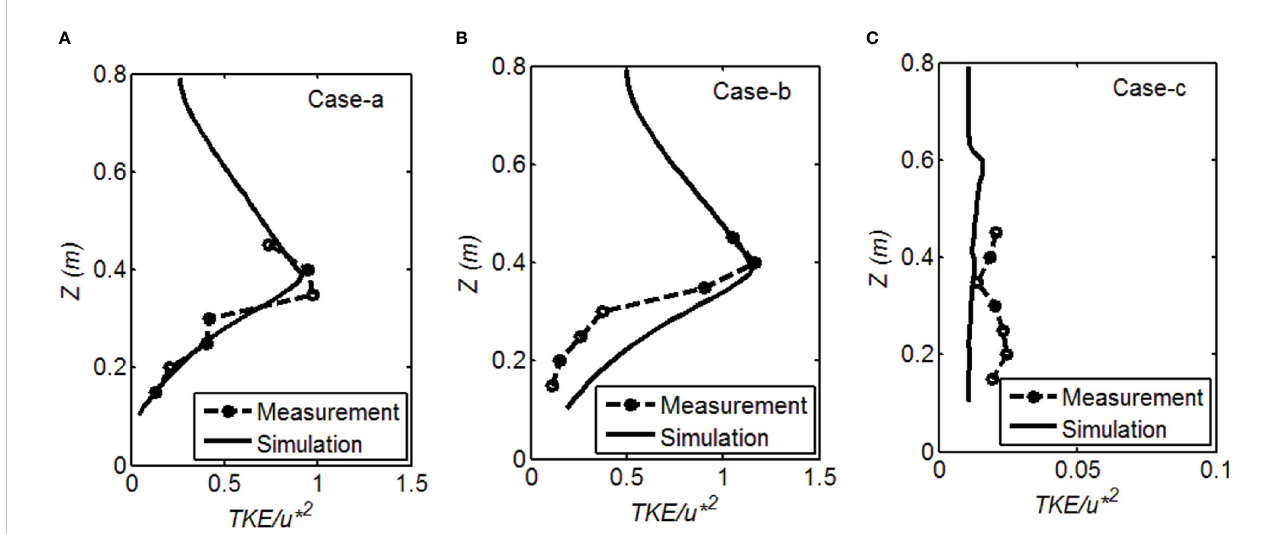
FIGURE 3 Comparisons of measured and simulated TKEs in Test 1: (A) Case-a, (B) Case-b, (C)